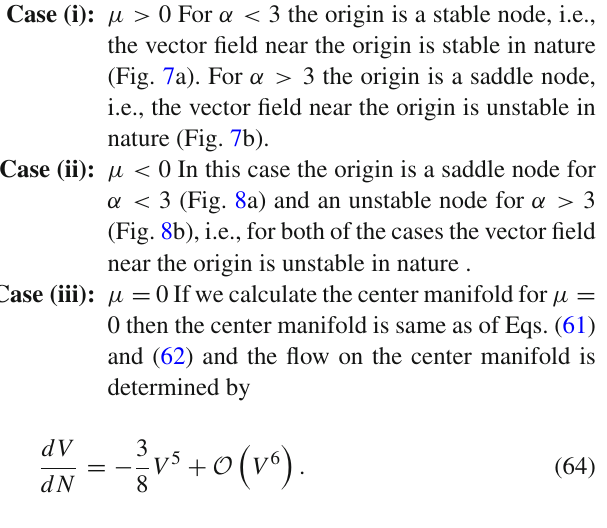
Fig. 7 Vector field near the origin in UV -plane for the critical point P 4 . L.H.S. figure is for ( α < 3 ,μ > 0) and R.H.S. figure is for ( α > 3 ,μ >